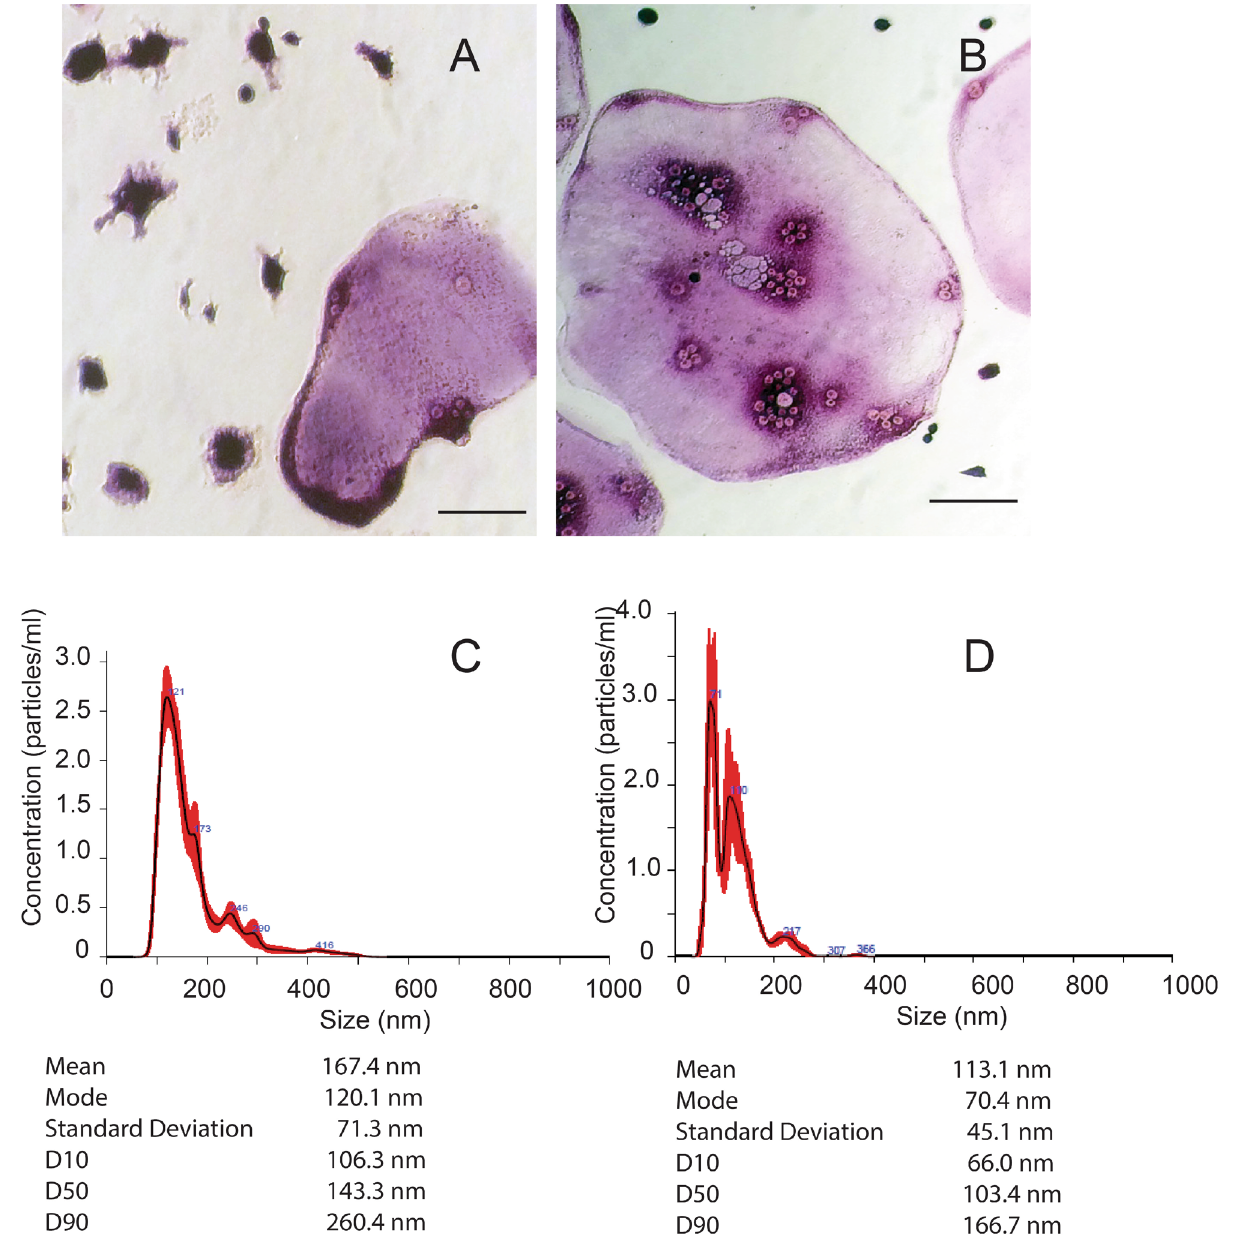
Figure 1. Characterization of EVs from RAW 264.7 osteoclast-like cells and primary mouse osteoclasts. RAW 264.7 cells or primary hematopoietic cells were stimulated to differentiate into osteoclasts. ( A ) RAW 264.7 osteoclast-like cells stained for TRAP activity (Pink is positive). Scale bar = 50 microns. ( B ) Primary osteoclasts stained for TRAP activity. Scale bar 50 microns. ( C ) Nanoparticle tracking of EVs collected from the conditioned media of RAW 264.7 osteoclast-like cells. ( D ) Nanoparticle tracking data of EVs collected from conditioned media of primary osteoclasts. The black track in the plots is the mean number for each size from 5 different 60 s trials, the red indicates the standard error boundaries at each size. The concentration of particles reflects the diluted concentration of the isolated EVs. Mean, and mode reflect the data from the particle size of the 5 trials. Standard Deviation reflects the spread of the data. D10, D50, and D90 indicates the size where 10, 50 or 90 percent of the detected particles are smaller, and reflects another measure of the spread of the